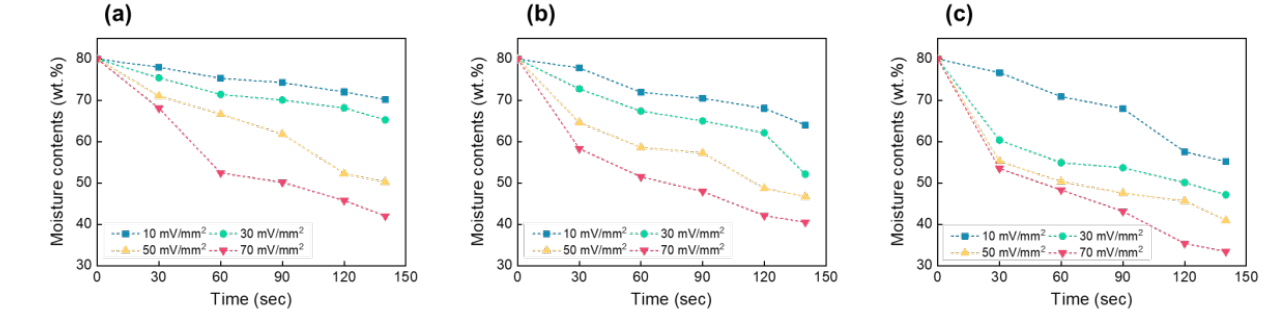
Figure 2. Moisture content with respect to processing time of sewage sludge cake thickness ( a ) 2 mm, ( b ) 1 mm, and ( c ) 0.5 mm.